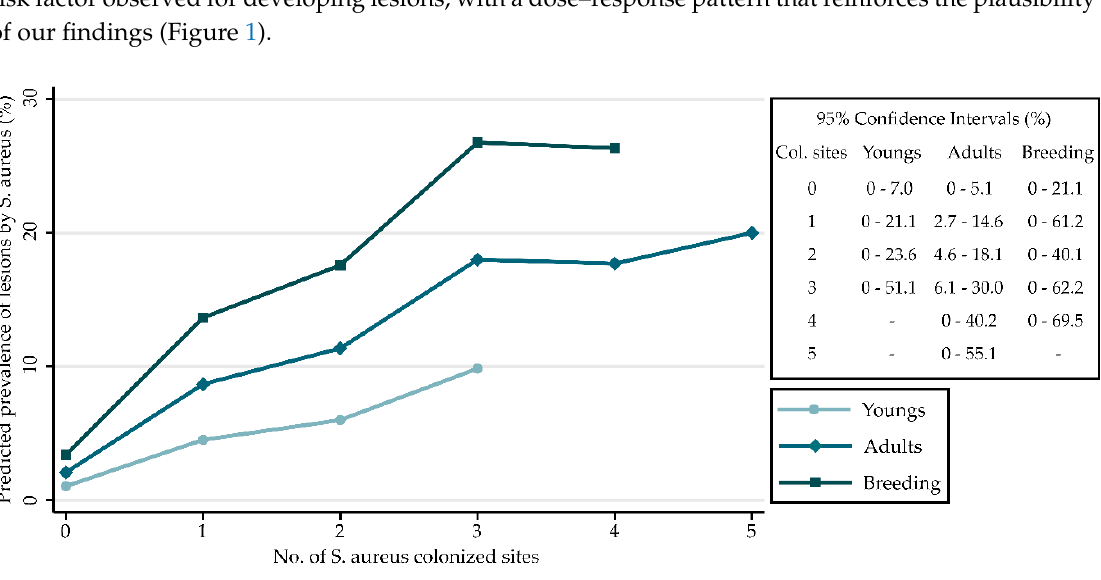
Table 3. Features of clonal lineages: spa ‐ types, spa ‐ repetitions, spa ‐ CCs, frequencies of spa ‐ types, relative prevalence and confidence intervals. Spa ‐ Type